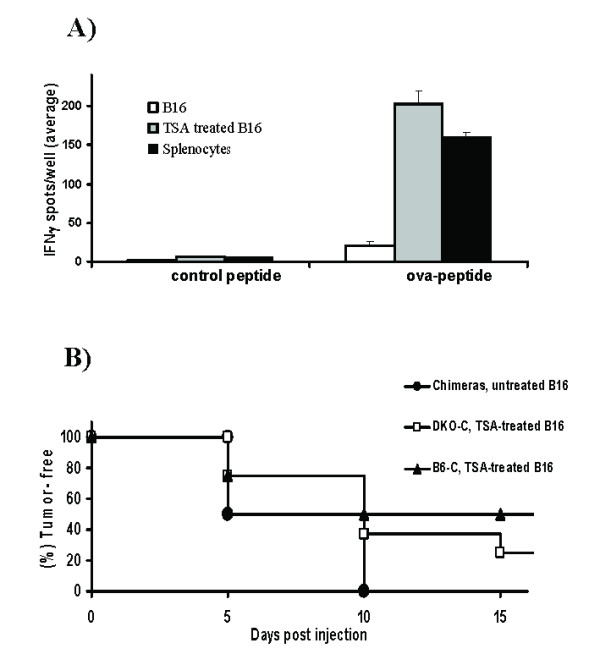
TSA treatment converts B16 melanoma cells to APCs. A) In vitro antigen presentation by TSA-treated (500 nM for 48 h) B16 cells. Purified T cells from OT-II mice were cultured with antigen-pulsed (ova-peptide322–338 or control peptide), irradiated B16 cells (TSA-treated or untreated) and splenocytes (from OT-II mice as control APCs) in a standard ELISpot assay to measure IFN-γ-secreting cells. B) Eight weeks after BM transplantation, control [B6-C] and MHC double knockout [DKO-C] chimeras were inoculated s.c. with TSA-treated B16 (1 × 105 cells) in the trunk and tumor-free survival was recorded. Control groups of B6-C and DKO-C chimeras were injected with untreated B16 cells. The survival curve for these two groups were coincident; therefore a representative plot [chimeras, untreated B16] showing the tumor-free survival of these controls is presented. Results from two independent experiments (four chimeras/group/experiment) are presented in this figure.